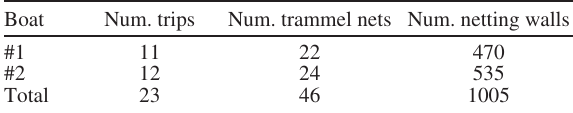
Table 1. – Summary of number of fishing trips, trammel nets and netting walls surveyed on Mallorca Island,